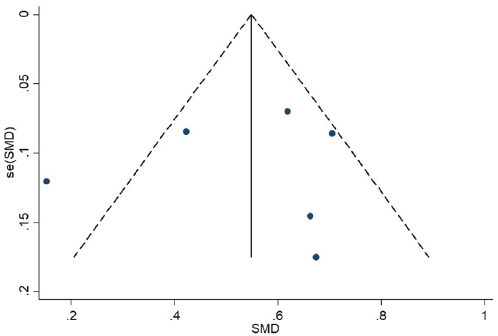
Figure 3. Funnel plot of the meta-analysis between baseline NLR level and poor functional outcome (mRS > 2) at 3 months. NLR neutrophil to lymphocyte ratio, mRS modified Rankin